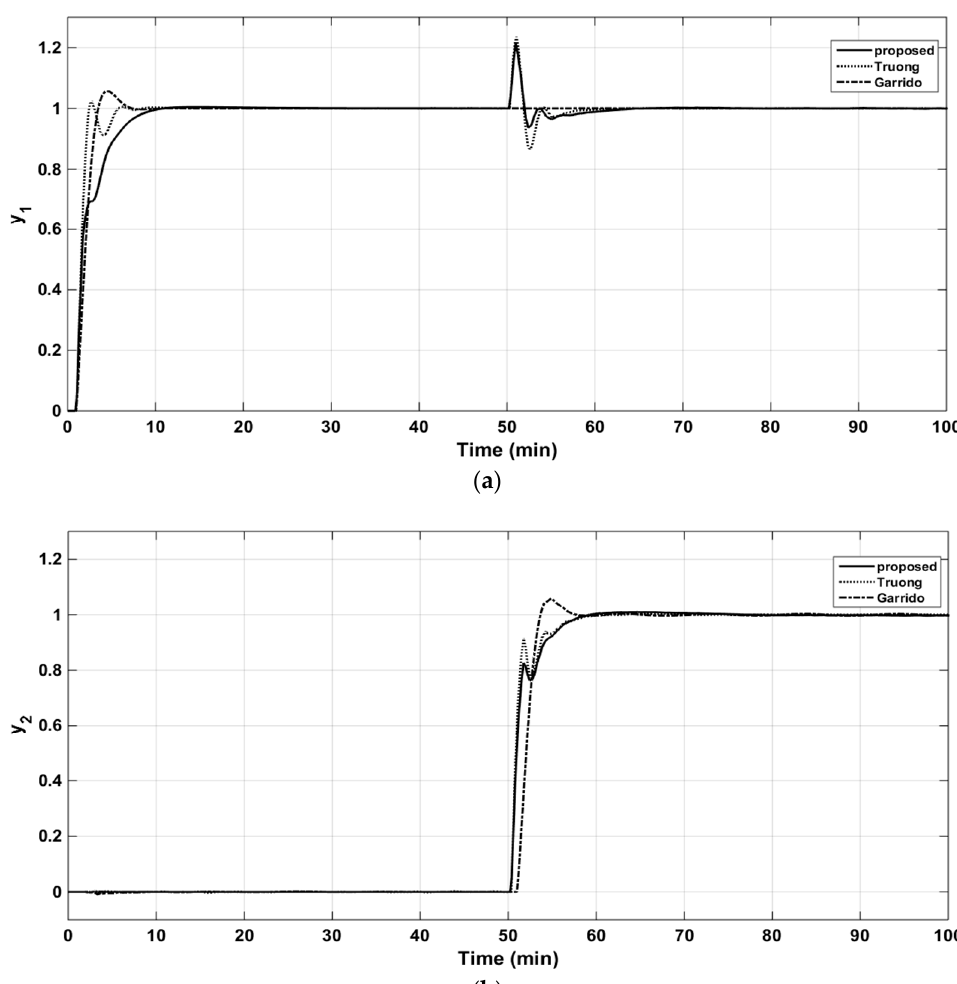
Figure 15. Closed-loop responses to the unit step changes in the set-point of loop 1 (VL column) ( a ). Closed-loop responses to the unit step changes in the set-point of loop 2 (VL column) ( b ).